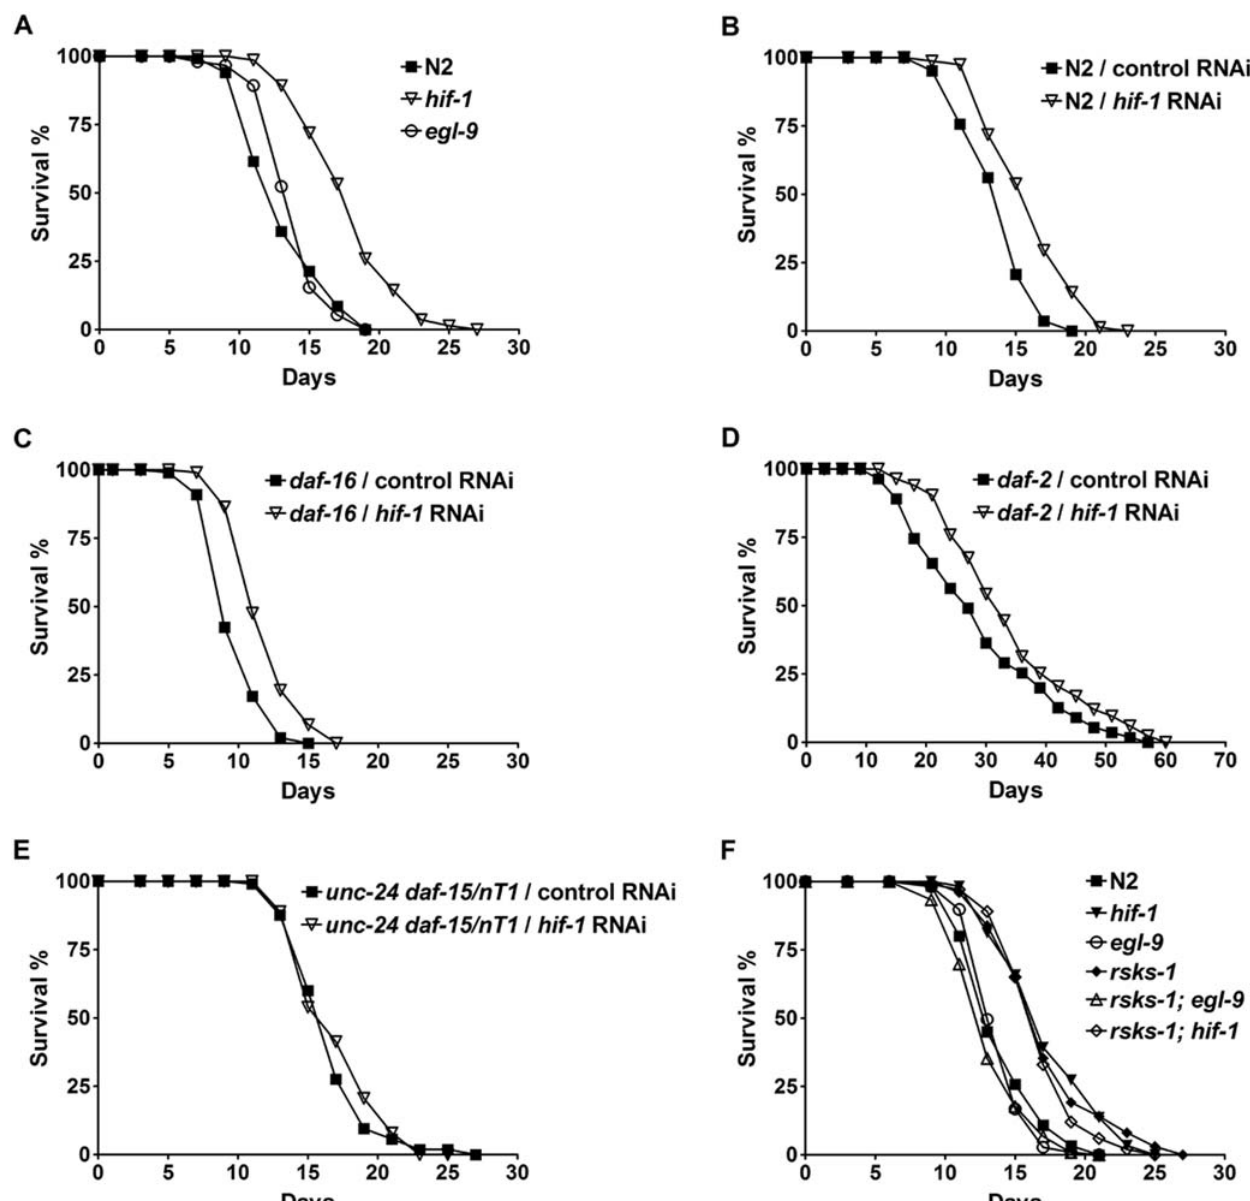
Figure 1. HIF-1 functions downstream of S6K to modulate C.elegans lifespan. (A) The hif-1(ia04) deletion mutant extends lifespan, whereas the egl- 9 (sa307) deletion mutant does not affect lifespan significantly under standard lab culture conditions. (B)–(D) Inhibition of hif-1 by RNAi extends lifespan of (B) wild-type N2, (C) daf-16(mgDf47) , and (D) daf-2(e1370) animals. (E) Inhibition of hif-1 by RNAi does not further extend lifespan of an unc-24(e138) daf-15(m634)/nT1 heterozygous mutant. (F) egl-9 suppresses lifespan extension by the rsks-1(ok1255) mutation, and hif-1 does not further increase lifespan of rsks-1 . Each of the lifespan experiments was performed twice with consistent results. Quantitative data and statistical analyses for the experiments shown here and the repeated experiments are included in Table 1 and Table S1,